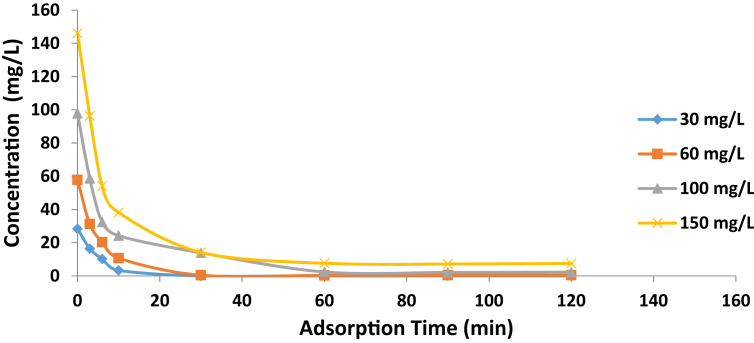
Initial concentration effect on the equilibrium removal of Pb2+ onto acid activated Aloji clay (temperature = 30 °C, rpm = 140, V = 100 ml, W = 0.10 g, pH 7).